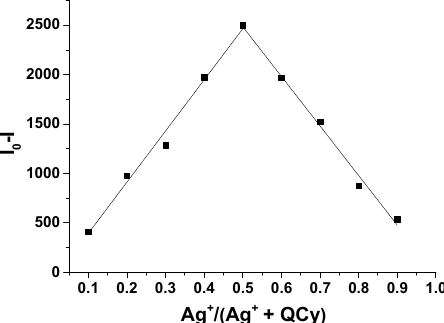
Figure 6. Fluorescence at 760 nm of QCy and Ag + in EtOH/PBS (1/9 v/v, pH = 7.0, 10 mM), with a total concentration of [QCy] + [Ag + ] = 10 μ M, indicating a 1:1 metal – ligand ratio of the complexation between QCy and Ag + .